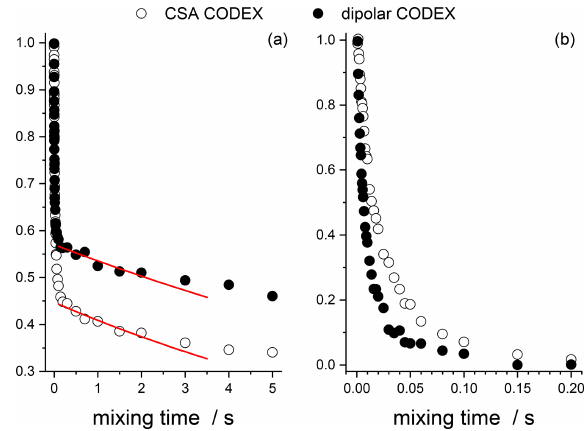
Figure 16. Direct comparison of the CSA and dipolar CODEX data in GB1 protein sample. (a) The mixing times dependences taken from Fig. 12 (CSA CODEX, without Z filter and without 2 H decou- pling) and Fig. 15 (dipolar CODEX, no 2 H decoupling). Red solid lines – the exponential fits of the initial parts of the spin-diffusion components. (b) Fast initial components of the decays after subtrac- tion the spin-diffusion components and normalization to the same initial